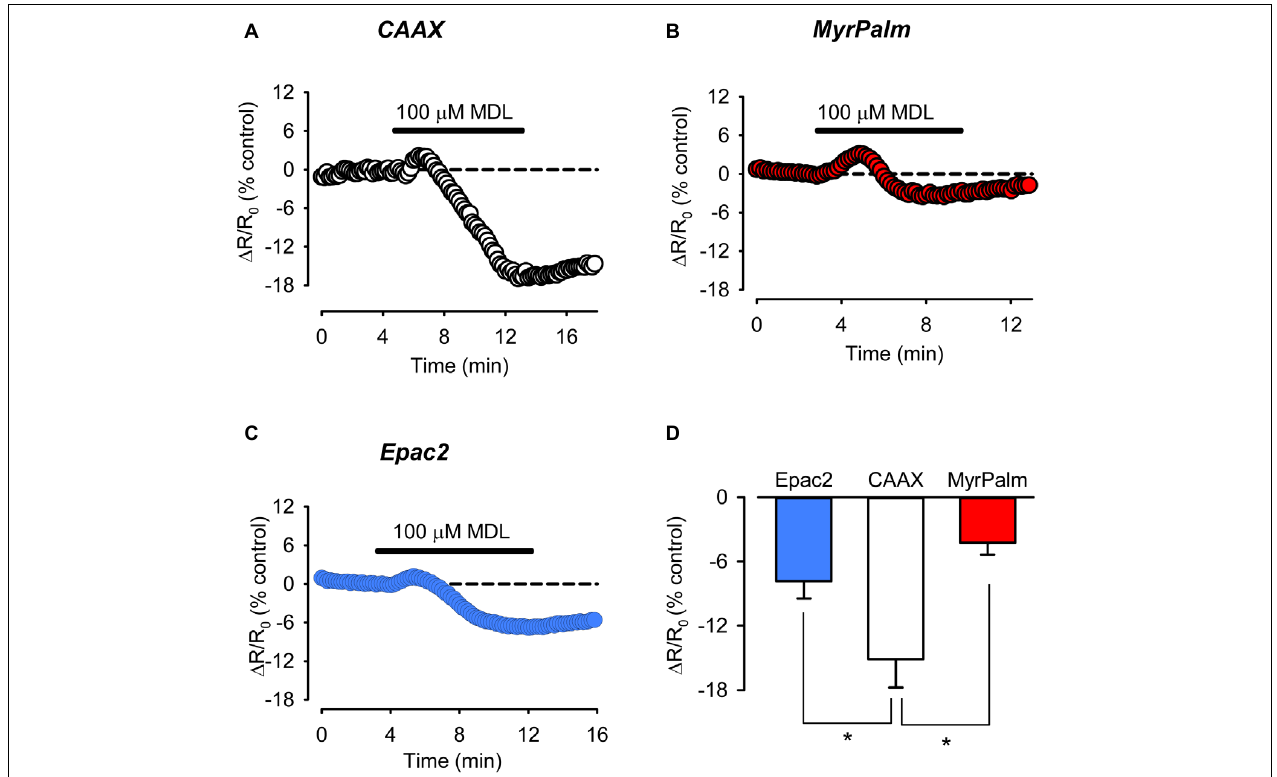
FIGURE 5 | Inhibition of basal AC activity leads to greater reduction of cAMP activity in non-raft associated membrane domains. (A–C) Representative time course of changes in the FRET response ( (cid:49) R/R 0 ) in cells expressing Epac2-CAAX (CAAX, white circles), Epac2-MyrPalm (MyrPalm, red circles), and Epac2-camps (Epac2, blue circles), under control conditions and following exposure to the AC inhibitor MDL12330A (MDL; 100 µ M). (D) Summary of average FRET responses to 100 µ M MDL in cells expressing Epac2-camps (n/N = 11/5, blue bar), Epac2-CAAX (n/N = 10/6, white bar), and Epac2-MyrPalm (n/N = 7/3, red bar). Epac2-CAAX response to 100 µ M MDL was significantly different from Epac2-camps and Epac2-MyrPalm responses ( ∗ p < 0.05, Kruskal–Wallis one-way ANOVA on Ranks followed by Dunn’s test for pairwise multiple comparisons). Reference line (dotted) at zero has been added for